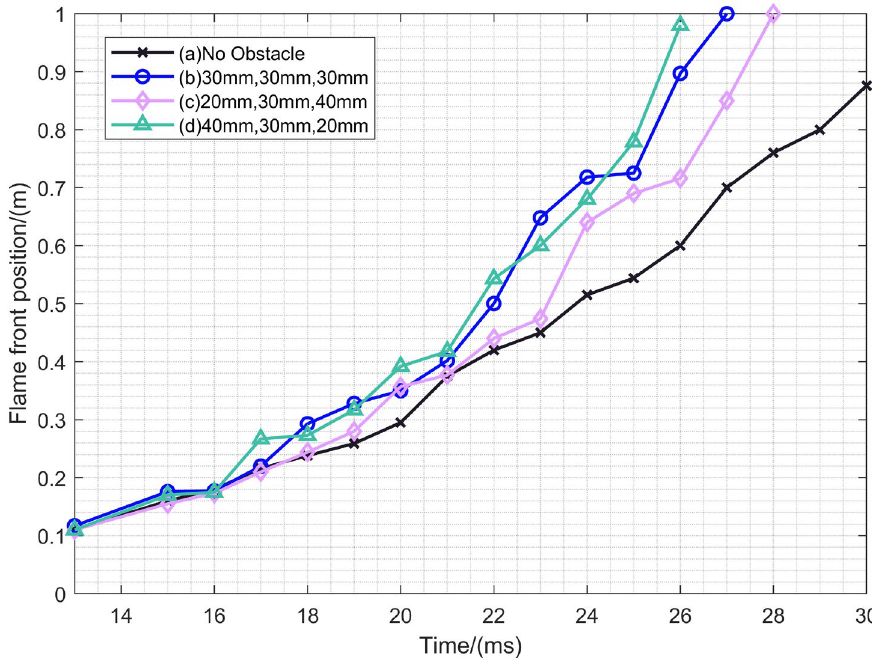
Figure 10. Comparison of flame position for four working conditions.